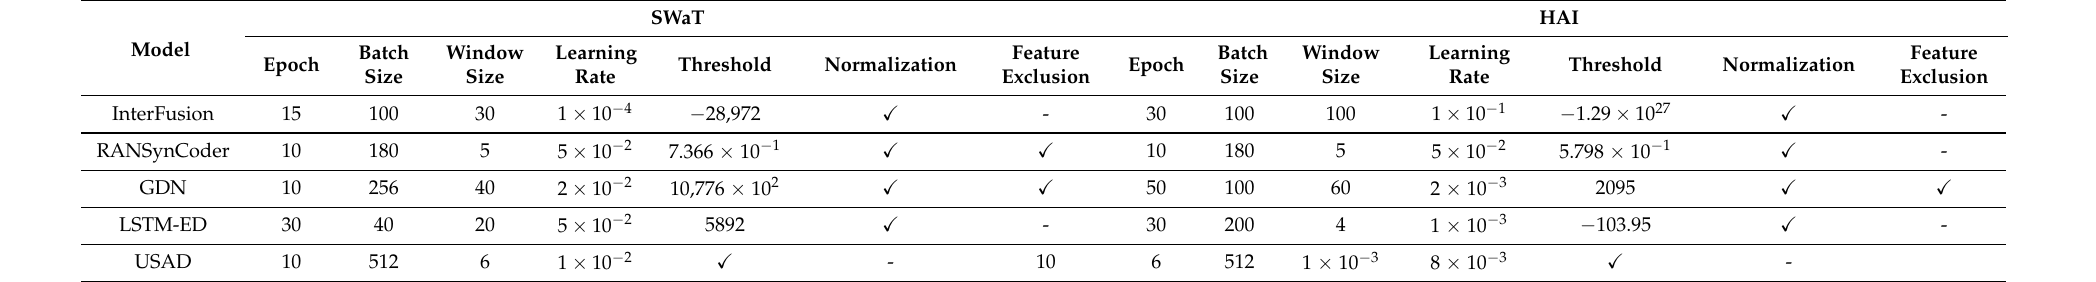
Table 4. Hyperparameter values for model